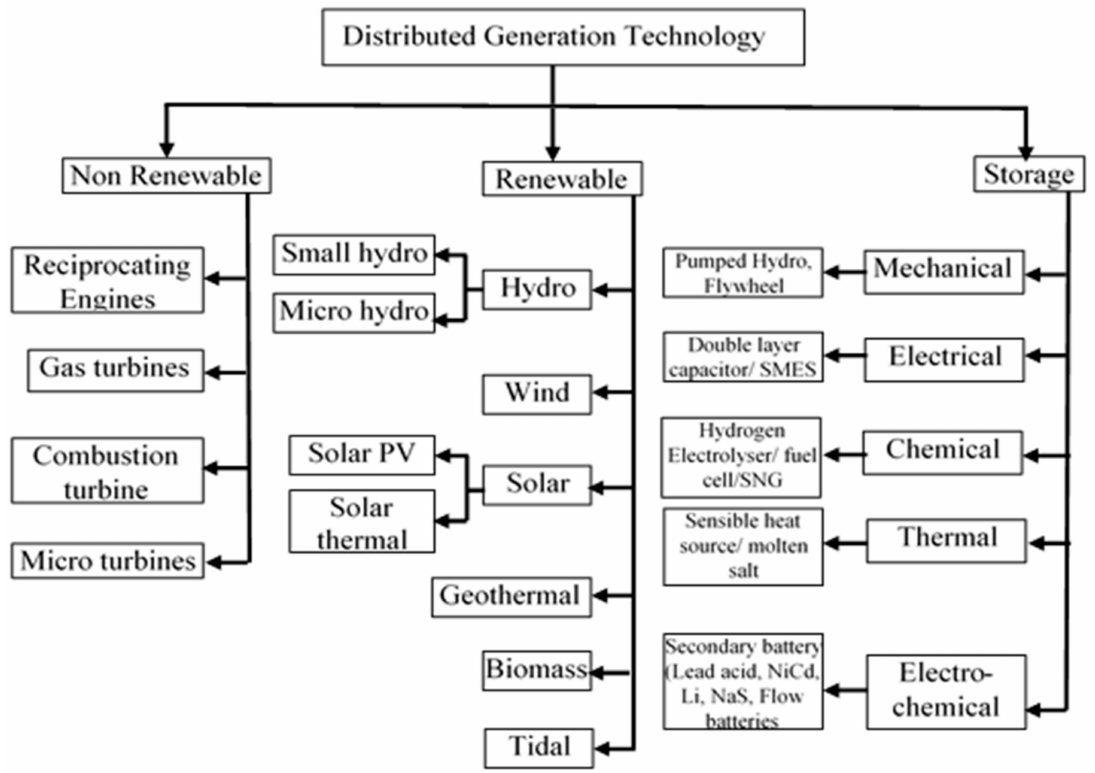
Figure 2. Classification of DG technologies